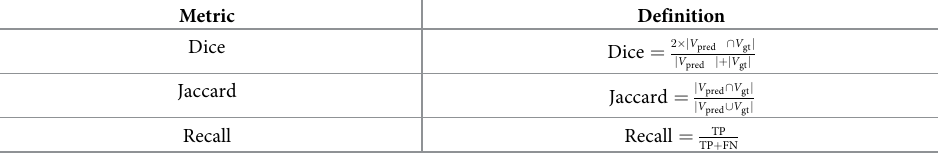
Table 7. The image segmentation evaluation metrics used in this paper and their definitions. TP (True Positive), FN (False Negative), FP (False Positive).